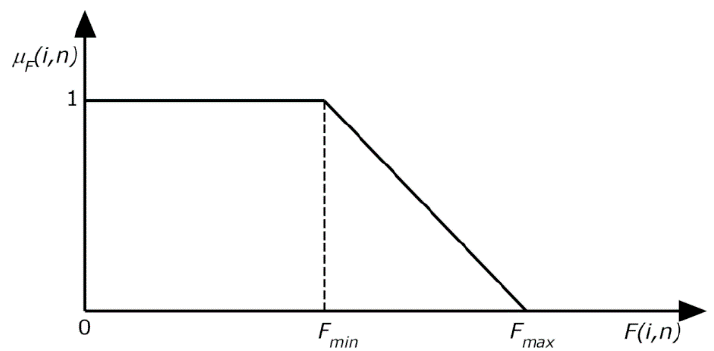
Figure 1. Linear fuzzy membership function.